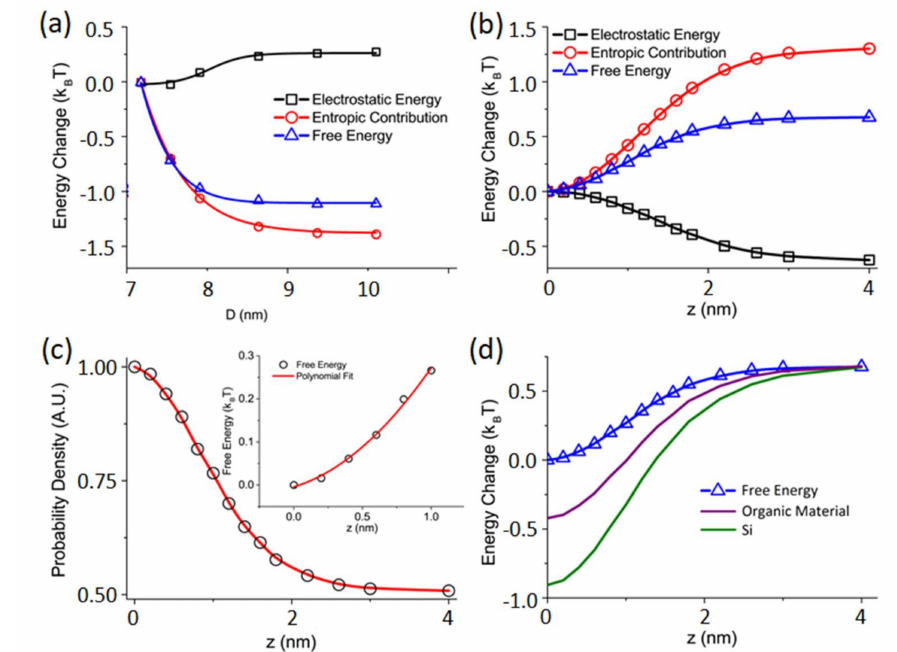
Figure 2. Dependence of the electrostatic energy, entropic contribution, and free energy on the other related factors for the nanoscale pentagon electric potential well in the saline solution. ( a ) Relation between the energy change and the diameter, D , along the z = 0 plane. ( b ) Dependence of the energy change at varied heights, z , above the structure plane. ( c ) Probability density as a function of the height, z . ( d ) The influence of di ff erent materials on the energy